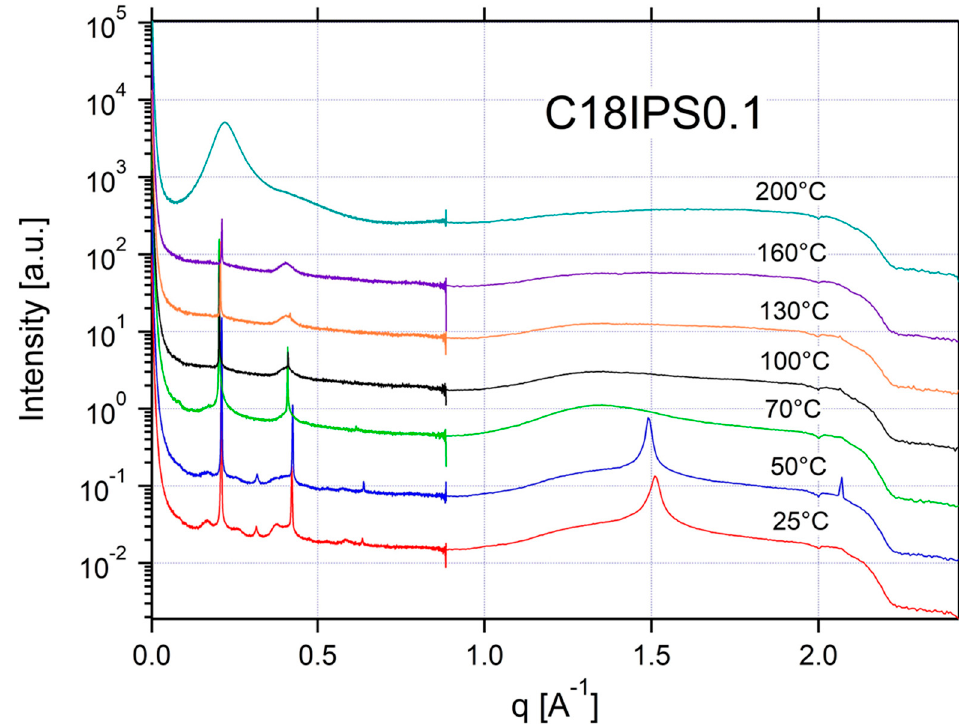
Figure A23. SAXS and WAXS data for 0.1:1 C18IPS:C18LiTFSI.